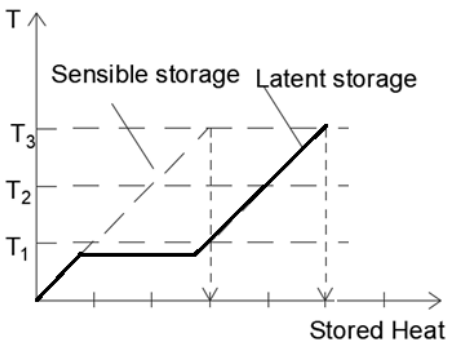
Figure 1 -Heat Accumulation Function in Time for Sensitive and Latent Containers [13]